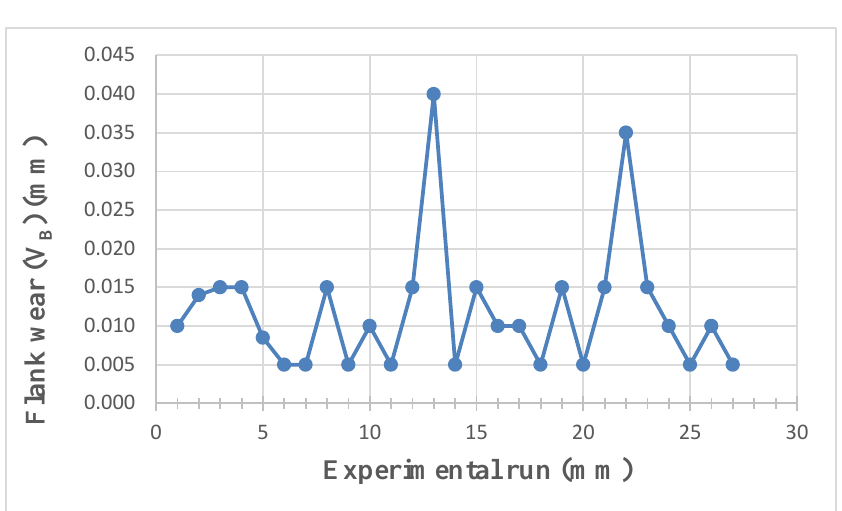
Fig. 2. Flank wear during each experimental